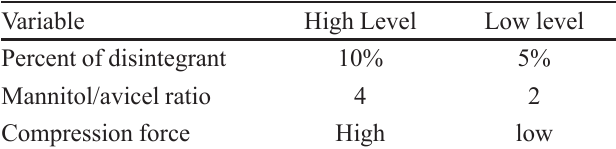
TABLE II - The actual values of different independent variables that used for determination of the optimum conditions for preparation of MLX orally disintegrating